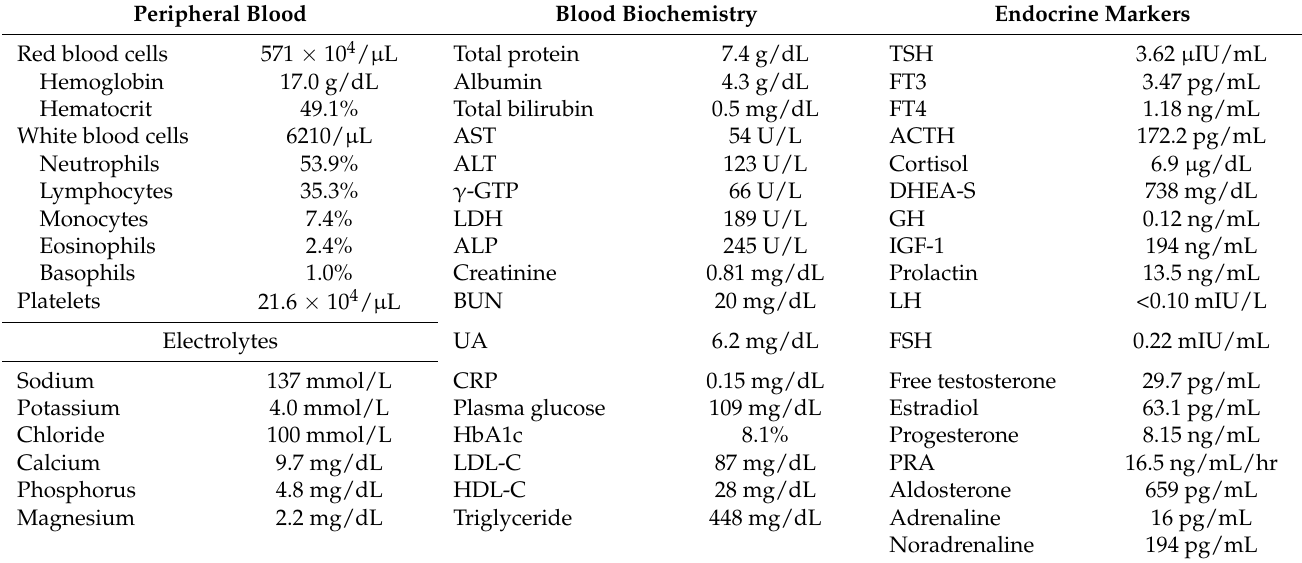
Table 1. Clinical parameters on admission in this 31-year-old